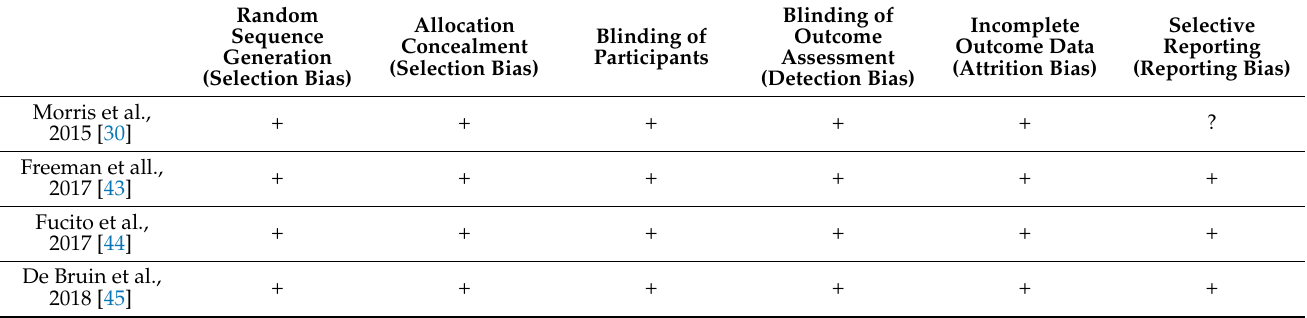
Table 1. Risk of bias summary on each risk of bias item for each included